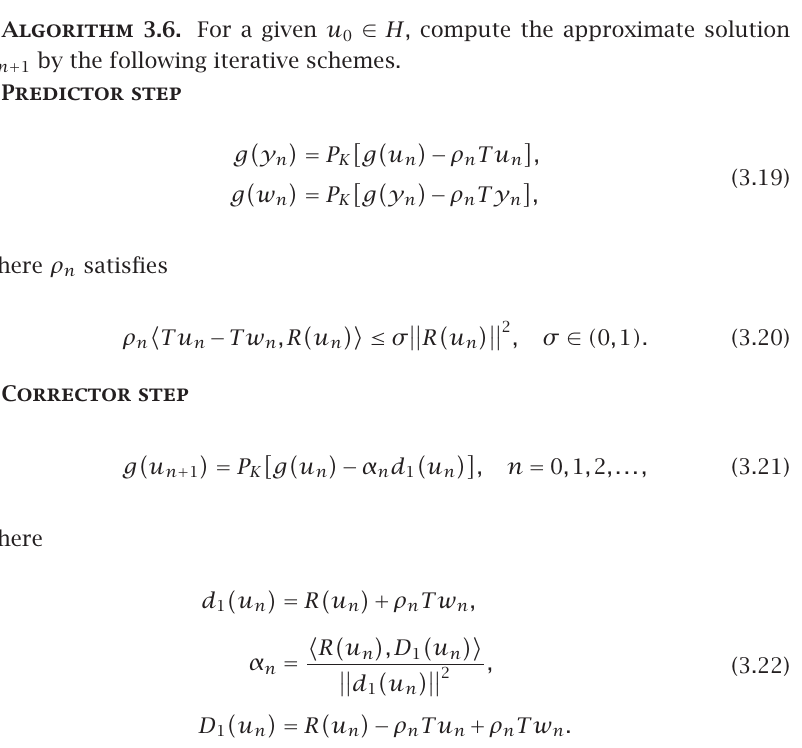
∈ H , compute the approximate solution 0